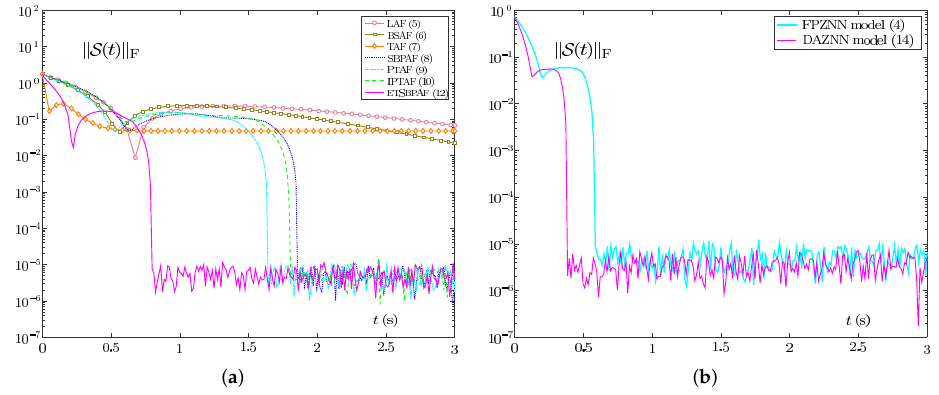
Figure 3. Dynamic characteristics of the (cid:107)S ( t ) (cid:107) F by FPZNN model (4) and DAZNN model (14). ( a ) FPZNN model (4) with various AFs. ( b ) FPZNN model (4) with AF (12) and DAZNN model